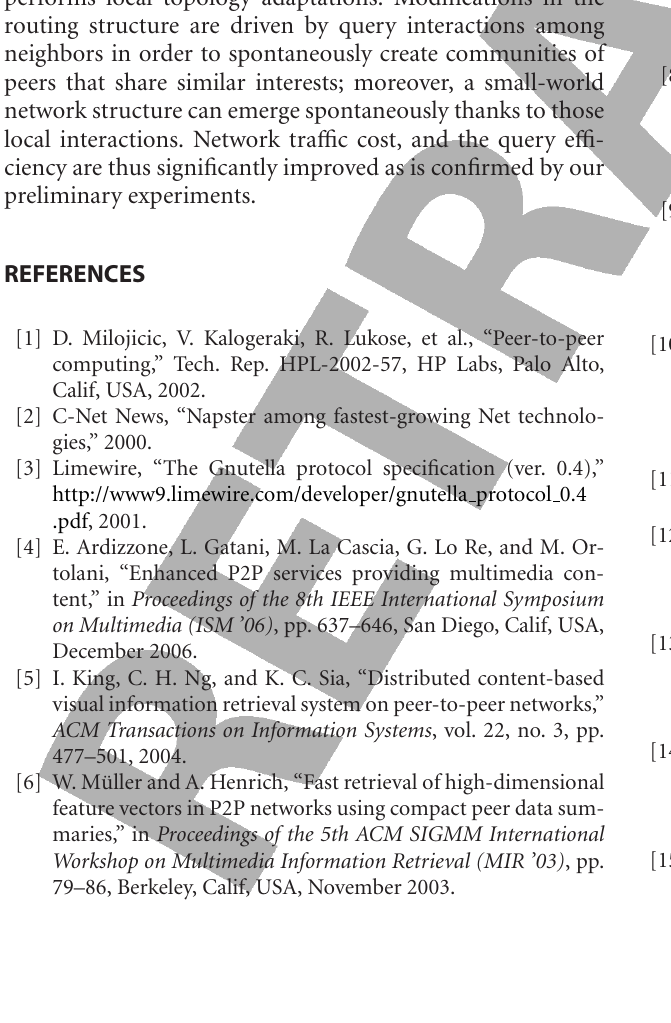
Figure 5: Relative variation of topological metrics using the 6th sequence of